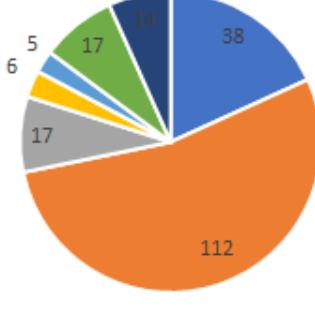
Figure 5. Respondents by working